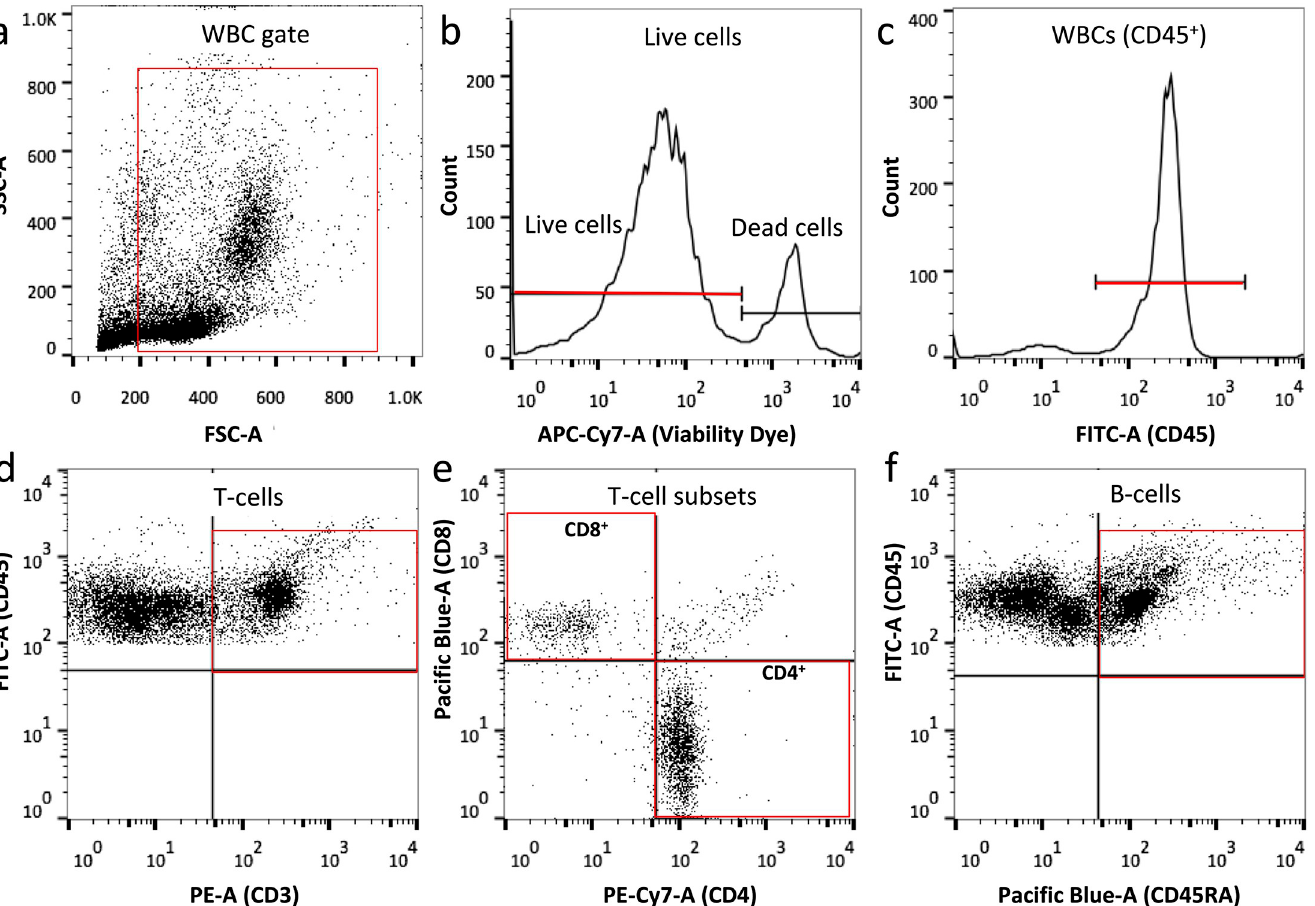
Fig 2. Gating strategy for T-, B- cells and CD4+, CD3+ T-cell subsets in blood and LNs. (a) Representative FSC/SSC dot plot diagram of blood cells. Red box indicates selection of white blood cells (WBCs) and exclusion of debris based on size and granularity. (b) Histogram indicating selection of live WBCs. (c) Histogram showing selection of WBCs out of live cells selected in (b), based on expression of CD45. (d) Selection of T-cells out of total CD45+ live cells, based on expression of CD3. (e) Selection of CD8+ and CD4+ T-cell subsets out of total T- cells as shown by red boxes. (f) Identification of B- cells out of total CD45+ live cells, based on expression of B- cell marker CD45RA. A similar gating approach was used for WBCs in LNs.